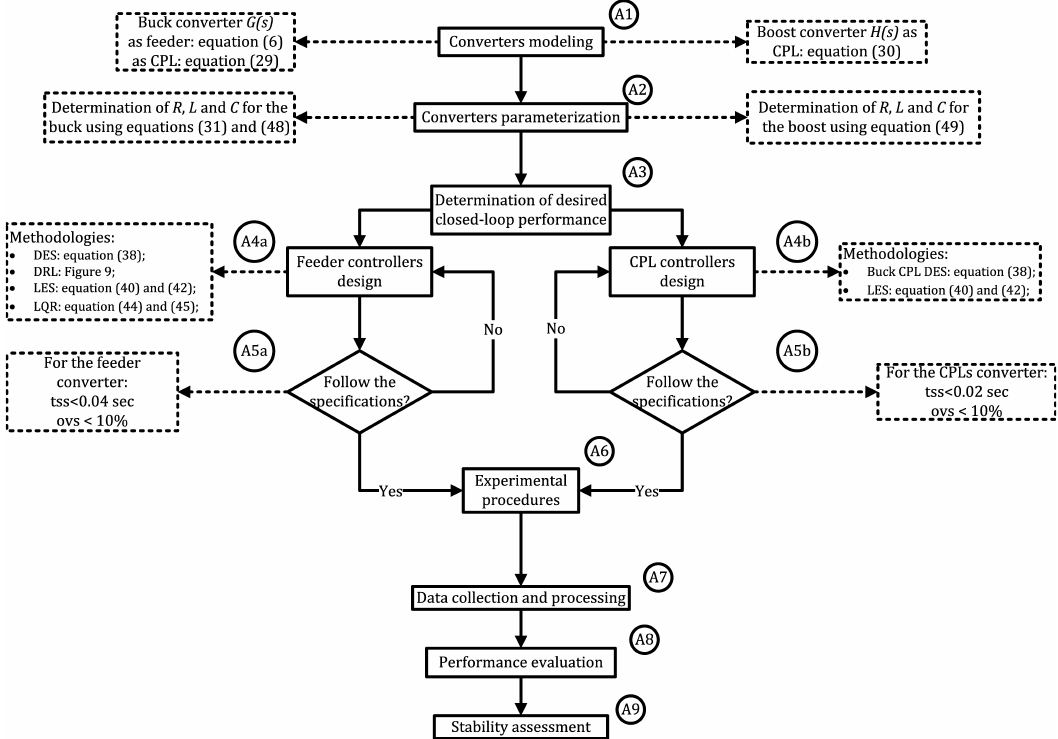
Figure 12. Flowchart of the methodology adopted in the